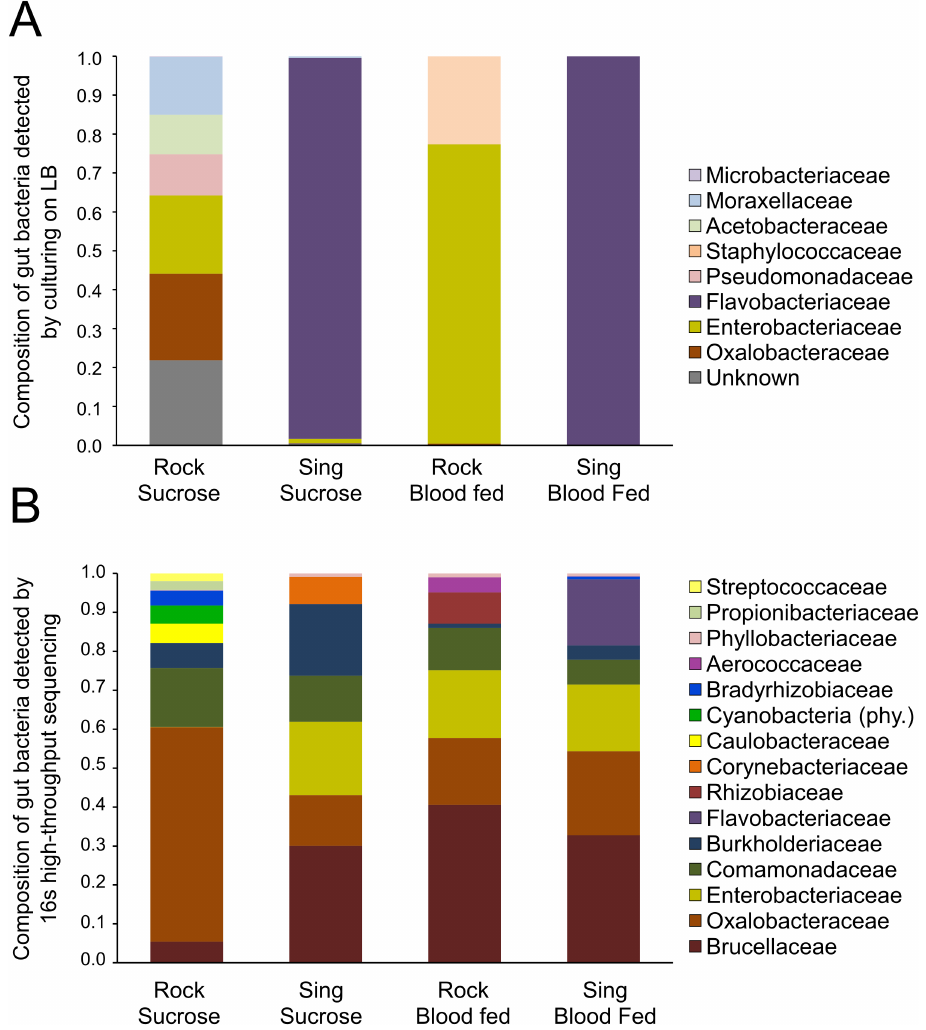
Fig 4. Family-level bacterial composition of Rockefeller and Singapore female midguts. (A) Family level composition of LB-cultivable bacteria in Rock and Sing: Using the same samples shown in the singletime point bacterial load analysispresentedin Fig 1, we identifieddistinct bacterial colony types culturedfrom each individualfemale midgut and sequencedthe 16S rRNA gene from each isolateto identify colony type to family level. Bacterial family counts from individualfemales were combined post hoc within each combination of strain and feedingstatus to obtain an overall percentage of bacterialfamily within each treatment group. LB-cultivable compositiondata for the other three strains shown in Fig 1 can be found in S2 Fig. (B) Family level composition using 16S rRNA high-throughput sequencing. We used Illumina MiSeq technologyto sequencethe V3-V4 hypervariableregions of the 16S rRNA gene from a pooledsubset of samplesfrom those used in the singletime point bacterial load analysispresentedin Fig 1 to determine their family-level16S midgut bacterialcommunity profile. Only OTUs representing > 1% of the total reads are represented here. Cyanobacteria are presented at the phylum level, as reads could not be classified accuratelybelowthis